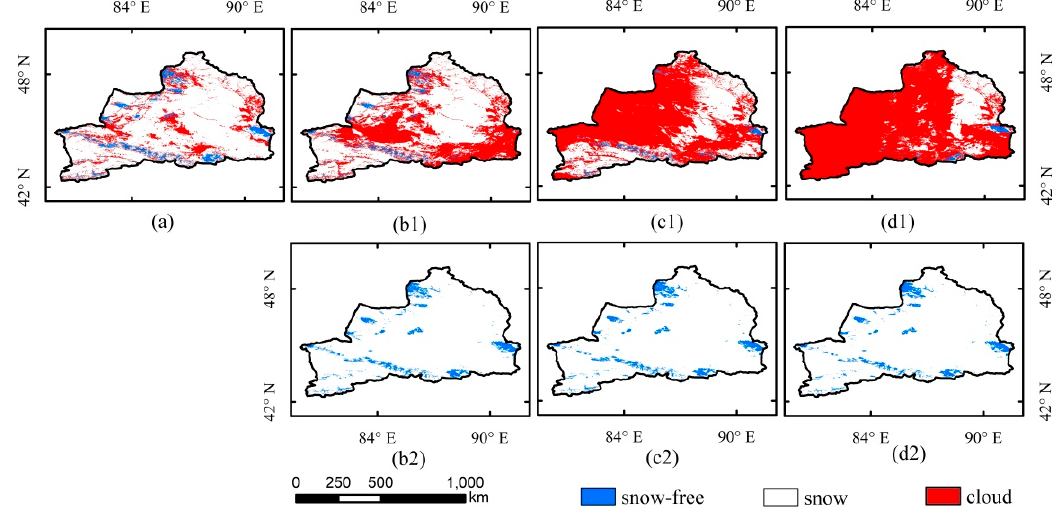
Figure 6. STCPI procedure for di ff erent CFs. ( a ) Selected true MOYD SCE on 10 February 2018. ( b1 , c1 , d1 ) Generated mask images with CFs of 25.06%, 57.77%, and 77.38%. ( b2 , c2 , d2 ) The cloud-free images generated by STCPI.